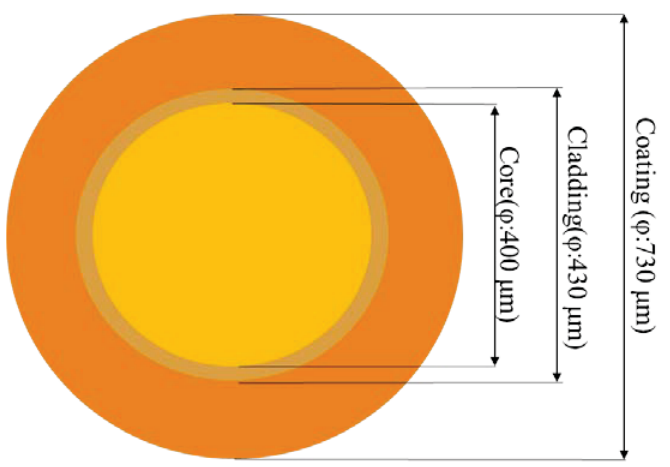
Figure 4. Schematic of the optical